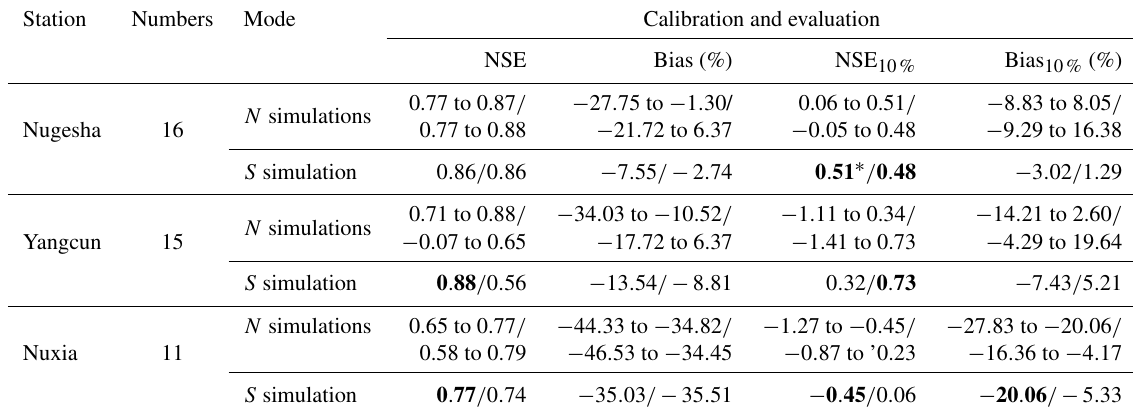
Table 1. Information of N simulations and S simulation during calibration and evaluation at three hydrological stations. Station